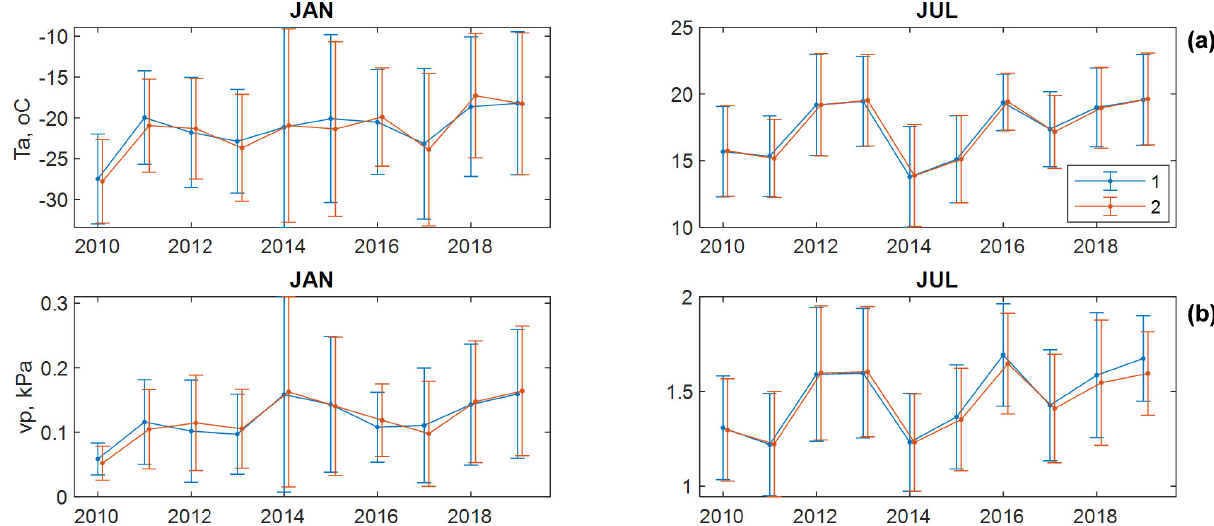
Figure 3. Monthly averaged air temperature (a) and water vapor pressure (b) at the hollow (1) and the ridge (2) in January and July. Bars show standard deviations for daily data.